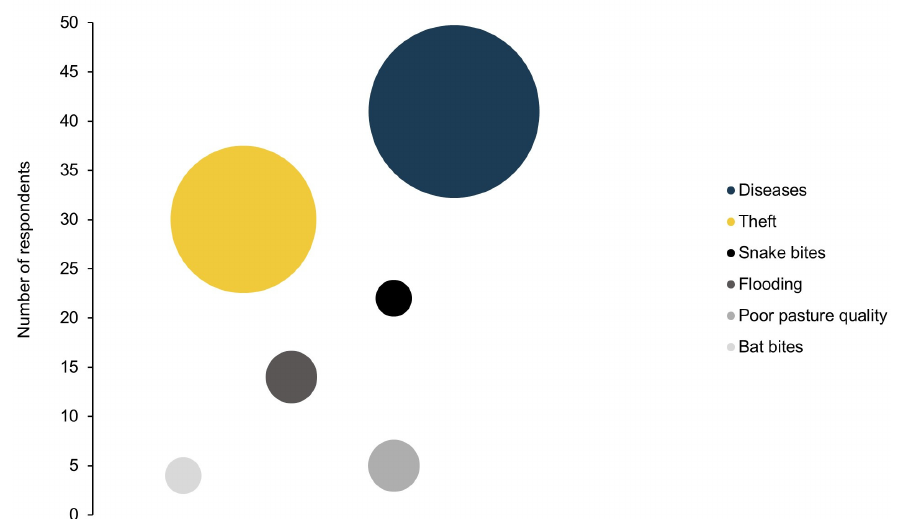
Figure 2. Main livestock challenges reported by ranchers. Bubble sizes are proportional to the number of respondents ranking a factor as the most important challenge, while the value on the vertical axis corresponds to the number of respondents listing that factor among the challenges of their livestock production.